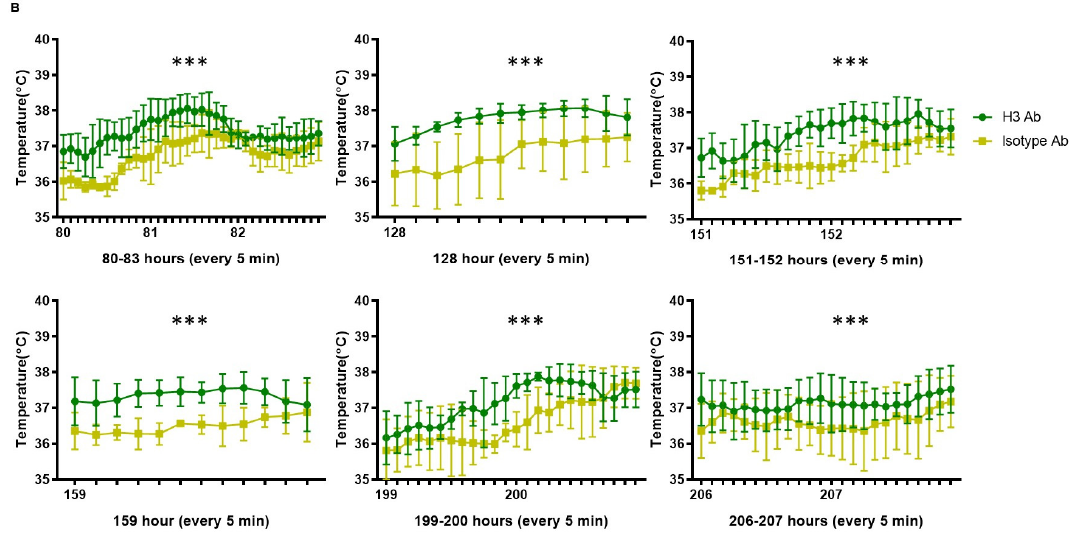
Figure 3. H3 Ab induces thermogenesis. Radiotelemetry devices were implanted into the mice. Following the surgical implantation and recovery period, H3 Ab or isotype control antibody was injected (50 µg/mouse, i.p ., 2 times/week) into C57BL/6J mice for 3 weeks, and temperature data from mice were recorded by the automated data acquisition system. ( A ) The upper graph indicates body temperature recorded for the first 10 days after 3 weeks of treatment with antibody. The blue arrows indicate time points where mice experienced a significantly increased body temperature. The lower graph indicates locomotor activity (LC). ( B ) Raw temperature data from the statistically significant time points indicated by blue arrows in ( A ). Significant differences are indicated by *** p < 0.0005 (two-way ANOVA). Values are the mean ± s.d. for n = 5 mice.